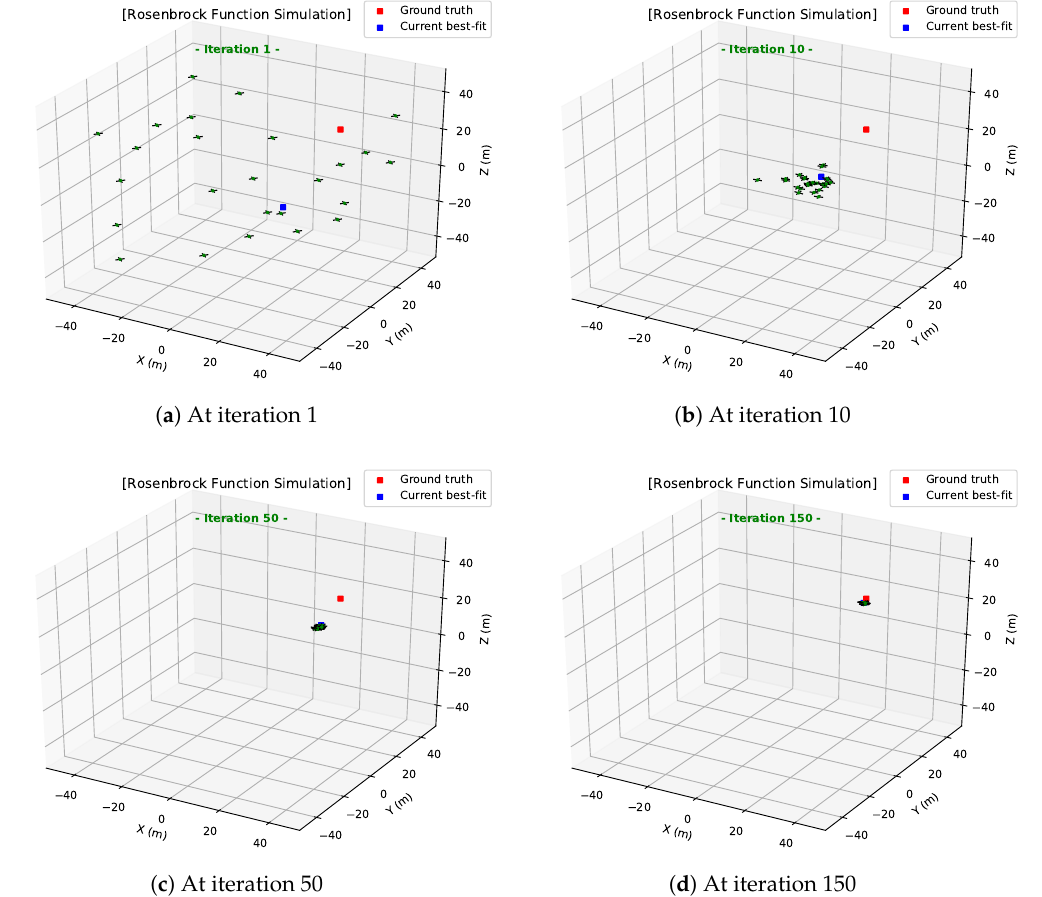
Figure 4. Screenshots of the simulation of Test Problem 1 by the proposed